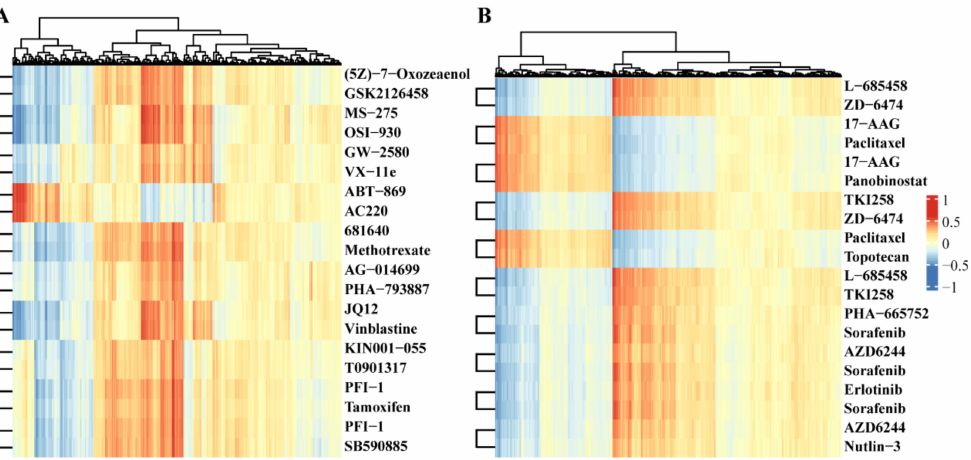
Figure 2. Heatmap of Pearson correlation coefficients of drugs in the activity of the multi-omics pathway. ( A ) Top 10 drug pairs based on functional similarity in GDSC database, in which each row represents a drug, and each column represents multi-omics pathways. The values are correlation coefficients. Drug names are listed at the right most columns. ( B ) Top 10 drug pairs based on functional similarity in the CCLE